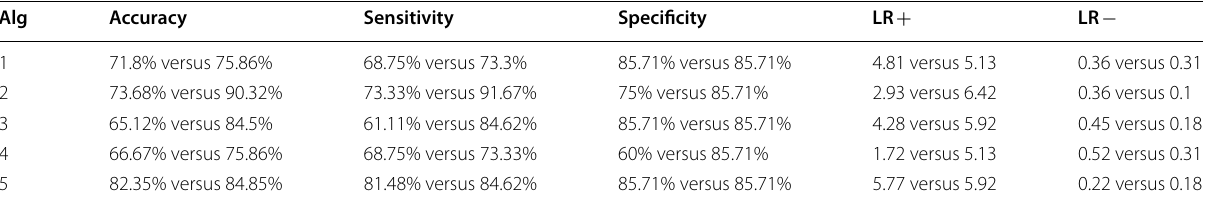
and LR ) of each algorithm evaluated by a + −